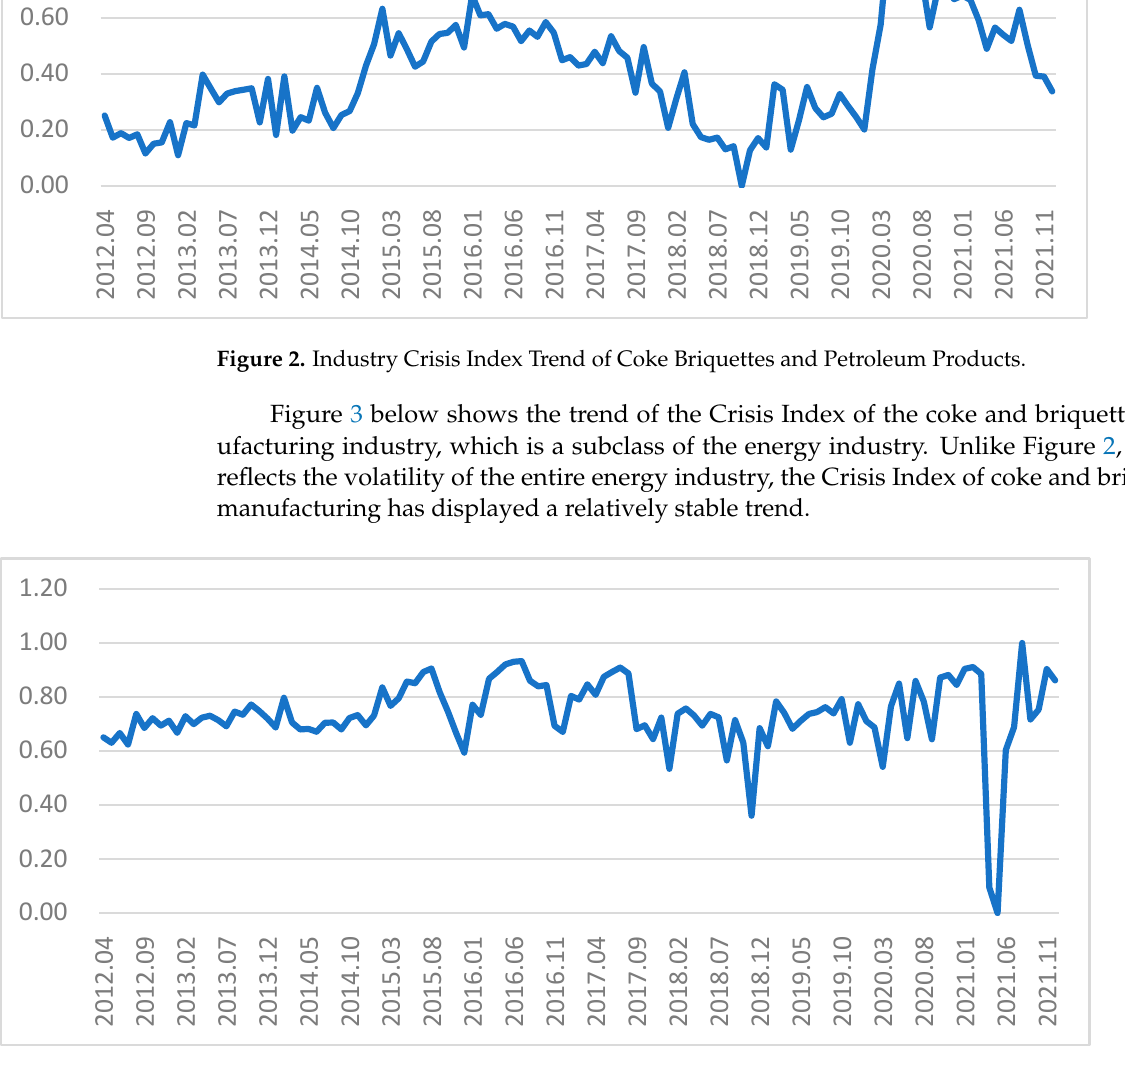
Figure 2. Industry Crisis Index Trend of Coke Briquettes and Petroleum Products.